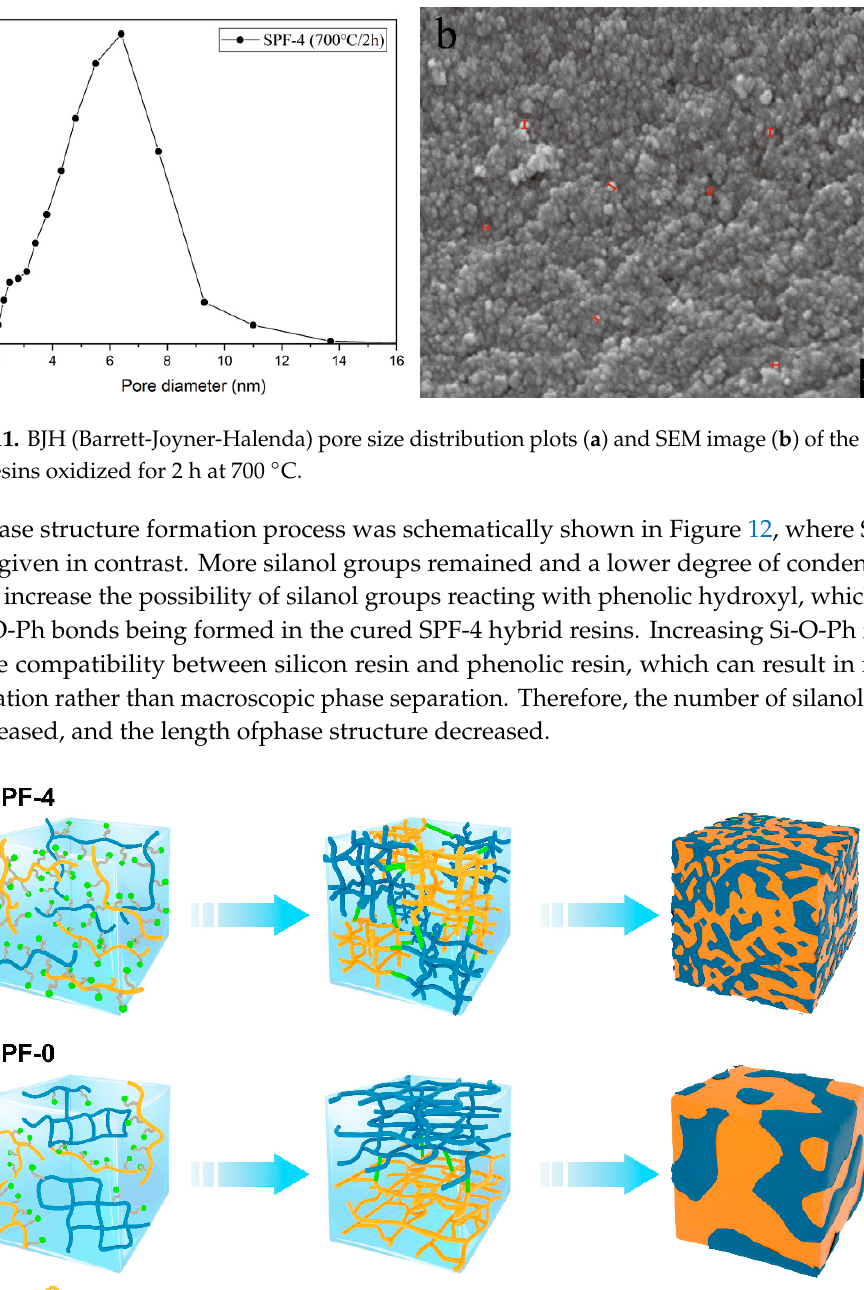
Figure 10. SEM images of the fractured surface of SPF ‐ 4 before ( a ) and after HF ‐ etching ( b ). Higher magnified images were inserted, respectively. The EDX result is correspondingly shown below in ( c ) and ( d ).